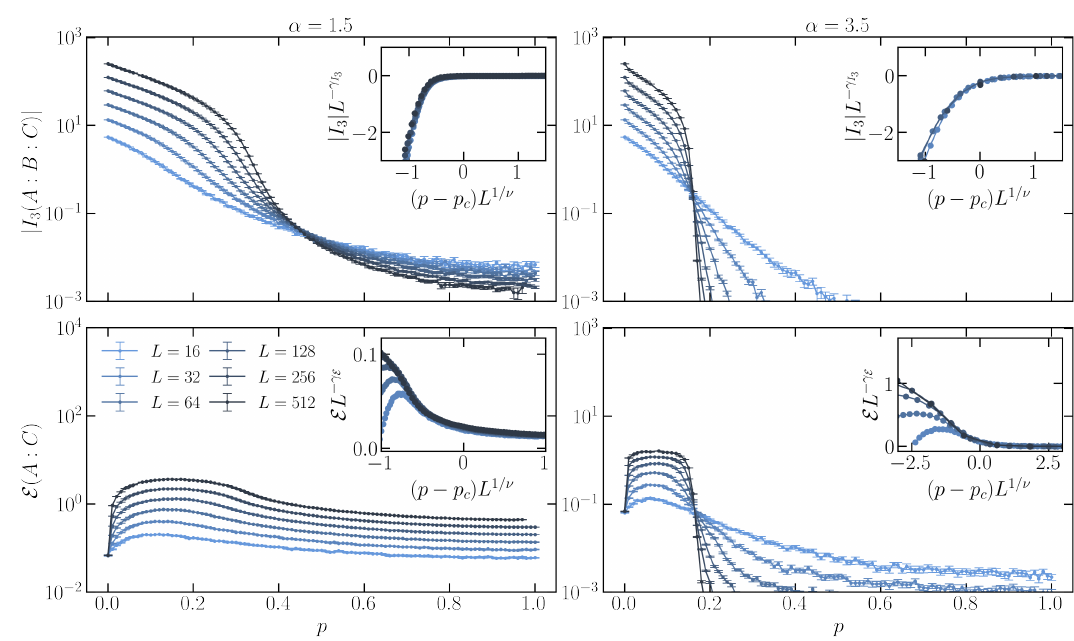
Figure 10: Data collapse for α = 1.5 and α = 3.5 of the tripartite mutual information (top panels) and the logarithmic negativity (bottom panels). For I , our FSS gives 3 ν = 2.5 ( 1 ) , γ = 0.3 ( 1 ) and p = 0.41 ( 1 ) for α = 1.5 and ν = 1.35 ( 2 ) , γ = 0.02 ( 2 ) I 3 c I 3 = 0.160 ( 2 ) . For the negativity we have ν = 3 ( 1 ) , p = 0.5 ( 1 ) and γ = 0.5 ( 2 ) and p E c c = 0.01 ( 1 ) and p = 0.161 ( 3 ) . for α = 1.5 and ν = 1.30 ( 2 ) , γ E c